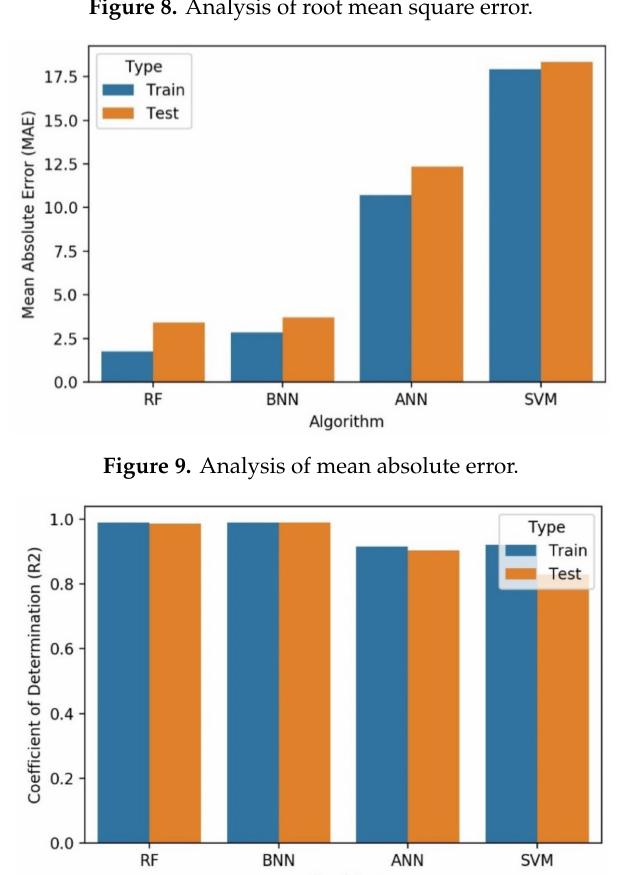
Figure 10. Analysis of coe ffi cient of determination (R 2